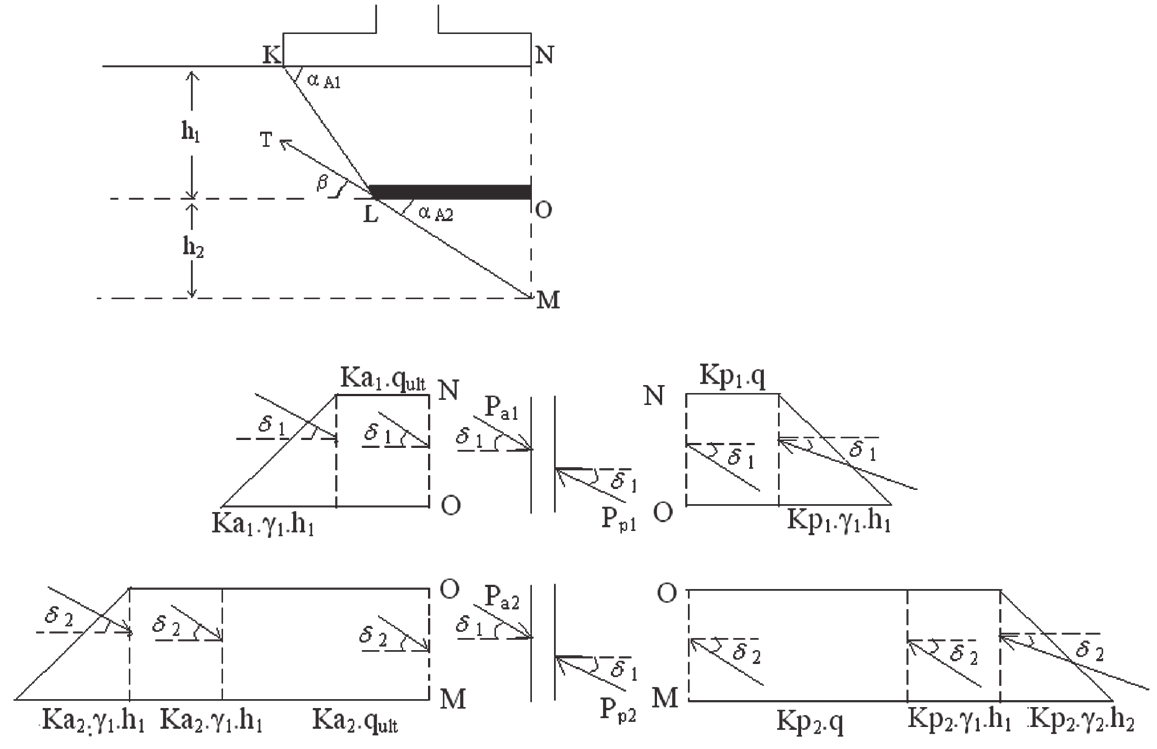
Fig. 2. Coulomb mechanism for reinforced two-layered